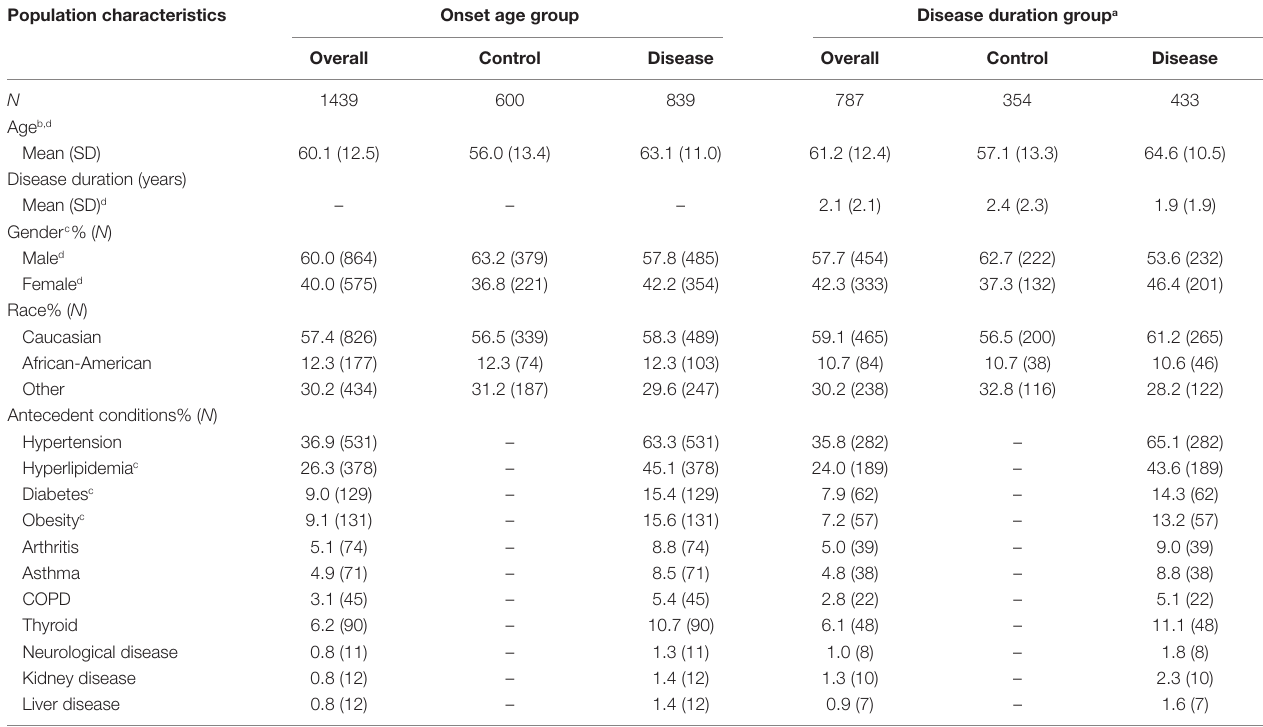
TaBle 1 | Demographics of emory clinic als population by als age of onset and disease duration. Population characteristics Onset age group Disease duration group a Overall control Disease Overall control